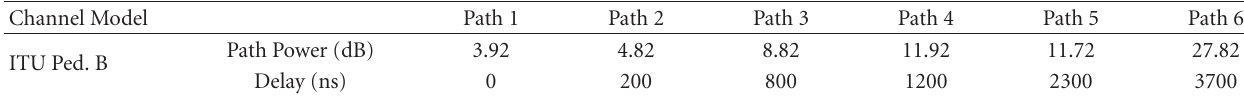
Table 2: Multipath channel model for ITU Ped